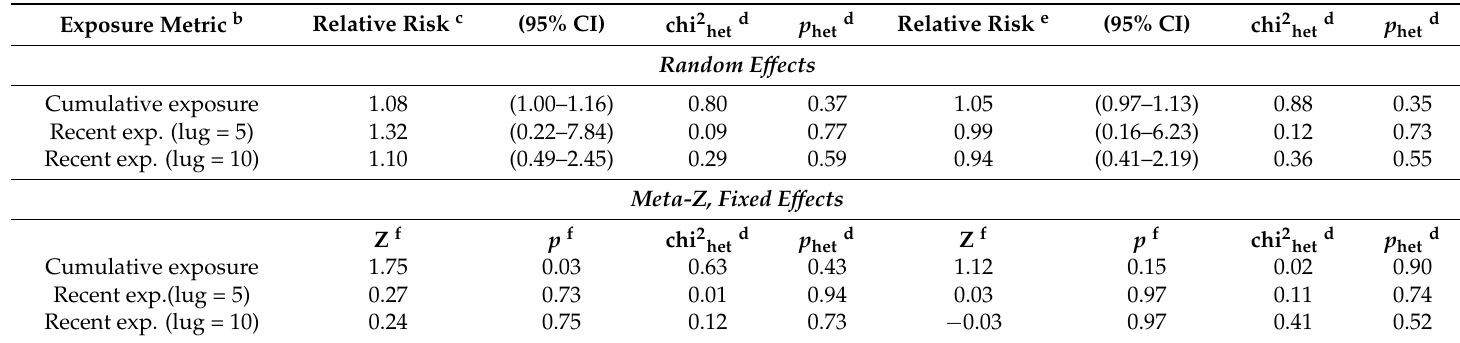
Table 12. Meta relative risk estimates and meta Z -statistics for acute myocardial infarction a obtained from Cox regression (internal analysis) and based on continuous measures of estimated carbon black exposure in two inception cohorts combined (US: follow-up ě 1979, Germany; 138 observed